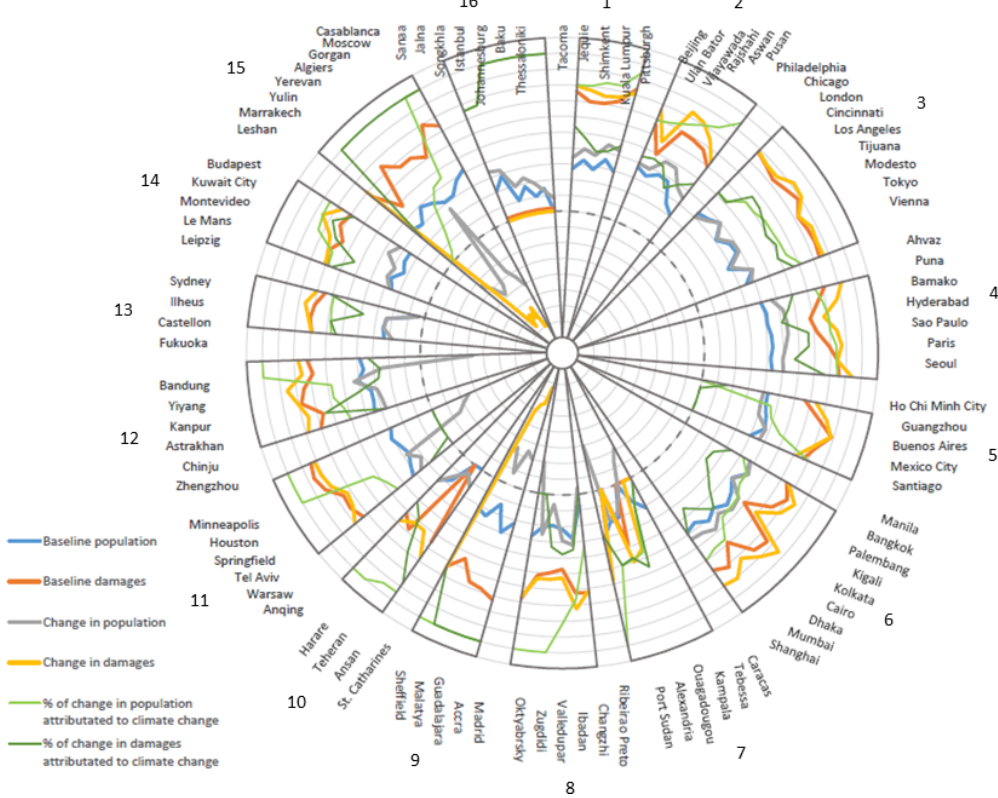
Figure 4. Radial plot of clusters of Fig. 3 – the city members of the 16 clusters of Fig. 3 are shown with their individual variable values. The scale is logarithmic for baseline and changes in population and damages, and linear for the percent of change attributed to climate change, with the dashed circle representing